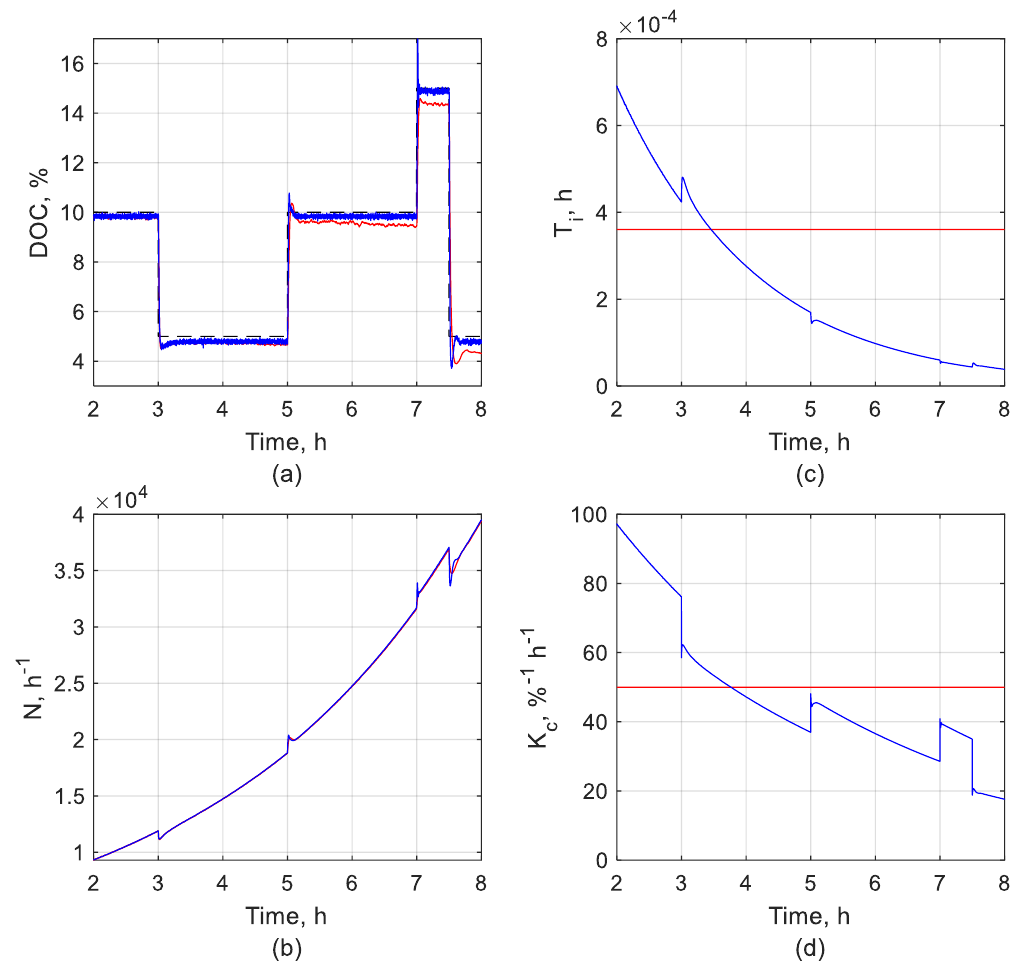
Figure 3. Trajectories of DOC ( a ), controller tuning parameter T i ( b ), stirring speed N ( c ), and controller tuning parameter K c ( d ). Set-point change: PI controller with fixed parameters (red), adaptive PI controller with Gain Scheduling (blue); DOC set-point (black).